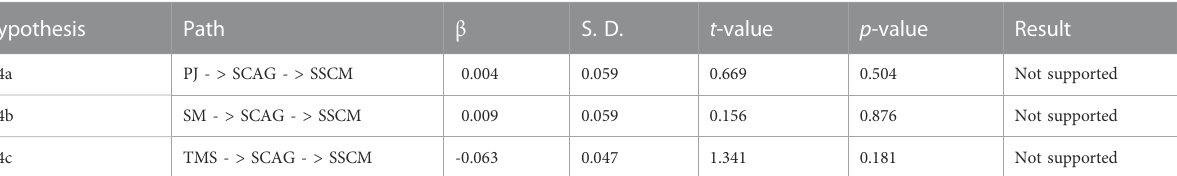
TABLE 5 Moderation hypothesis outcome.